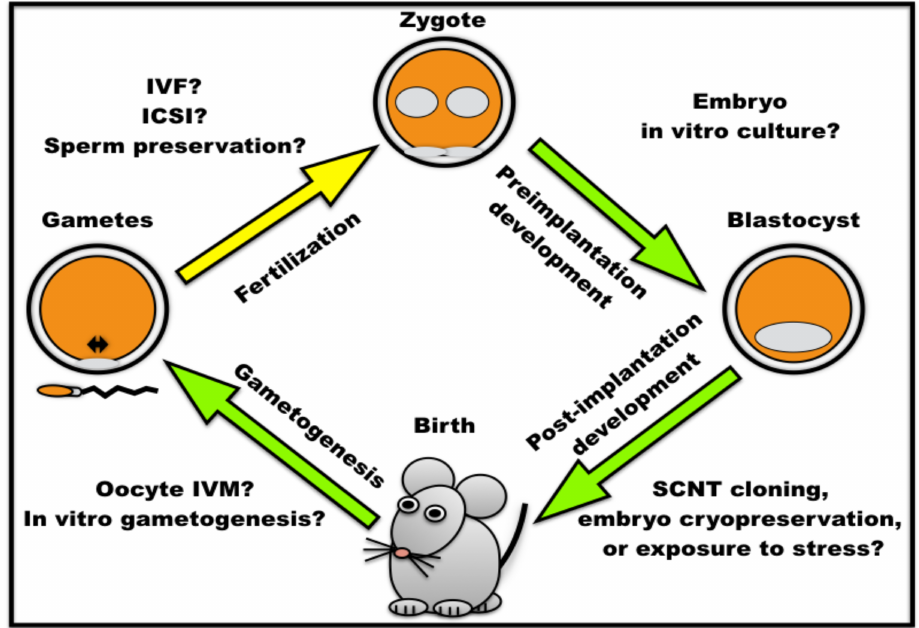
Figure 3. Potential contextual roles of autophagy during mammalian development. Autophagy is required during preimplantation embryonic development (zygote to blastocyst; green arrow) but the impact of in vitro embryo culture remains unknown. Post-implantation development requires autophagy (blastocyst to birth; green arrow) albeit it remains unclear if more challenging conditions to full-term development (e.g., cloning, embryo cryopreservation or exposure to in vivo stress) require autophagy. Autophagy is required for in vivo gametogenesis (animal to gametes; green arrow), although the impact of oocyte in vitro maturation (IVM) and in vitro gametogenesis would be informative. Autophagy during fertilization (gametes to zygote; yellow arrow) and sperm remodeling remains controversial. An attractive opportunity to contribute to this discussion is to determine if in vitro fertilization (IVF), intra-cytoplasmic sperm injection (ICSI), and sperm preservation methods (cooling, freezing or lyophilization) affect fertilization and the associated processes. SCNT: somatic cell nuclear